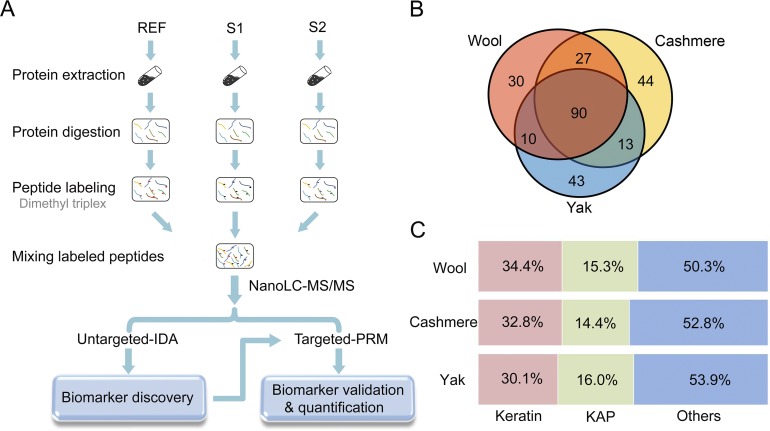
The quantitative proteomic strategy for fiber marker discovery and fiber proteome profiling results.(A) The schematic workflow of marker discovery and validation with combined untargeted and targeted proteomic strategies. Two replicates of a specific fiber sample (S1 and S2) were labeled with intermediate and heavy dimethyl tags, a fiber mixture from three species with a light dimethyl label served as reference (REF). The mixture of S1, S2 and REF was analyzed by nanoLC-MS/MS in IDA mode for fiber proteome profiling and marker discovery. Then peptide markers were validated and used for fiber quantification with the parallel reaction monitoring (PRM) approach. (B) Numbers of protein identification in cashmere, wool and yak fiber samples. The result shows large overlap of the fiber proteome among three species. (C) Percentage of keratin and KAPs identified in three types of fibers. Detailed GO classification for each identified protein is shown in S1 Table.